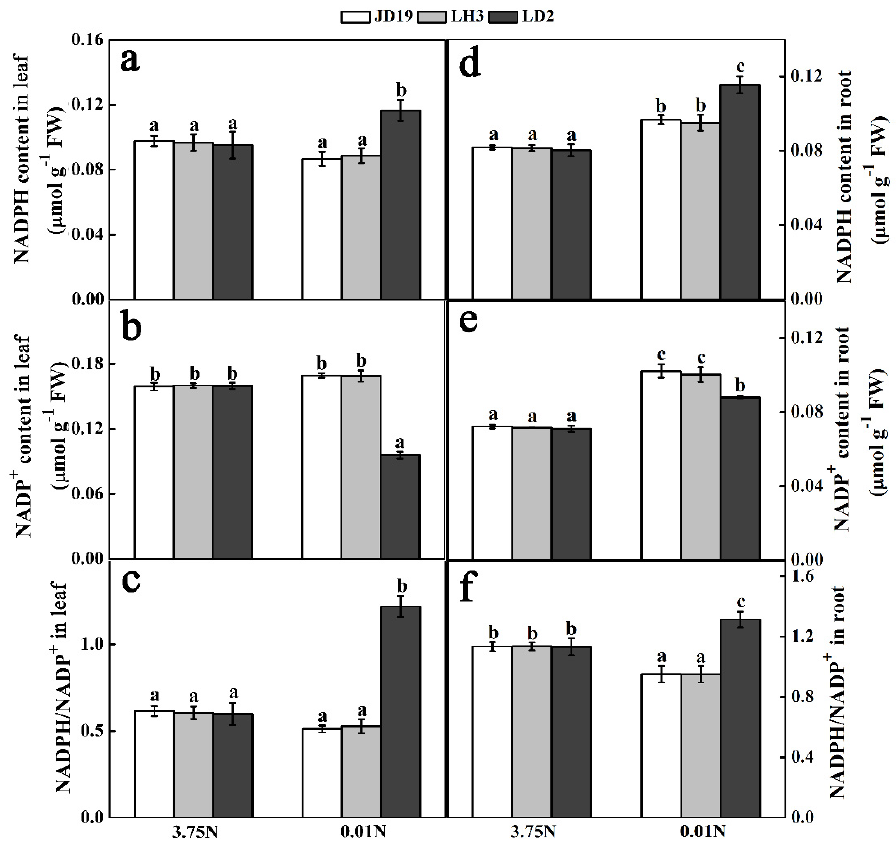
Figure 4. Effects of NADPH levels in three soybean cultivars under low-N stress. ( a ) NADPH content ( b ) NADP + content ( c ) NADPH/NADP + ratios in the leaves ( d ) NADPH content ( e ) NADP + content ( f ) NADPH/NADP + ratios in the roots. Data are means ± SE ( n = 3, p < 0.05). The letters show significant differences under N conditions.